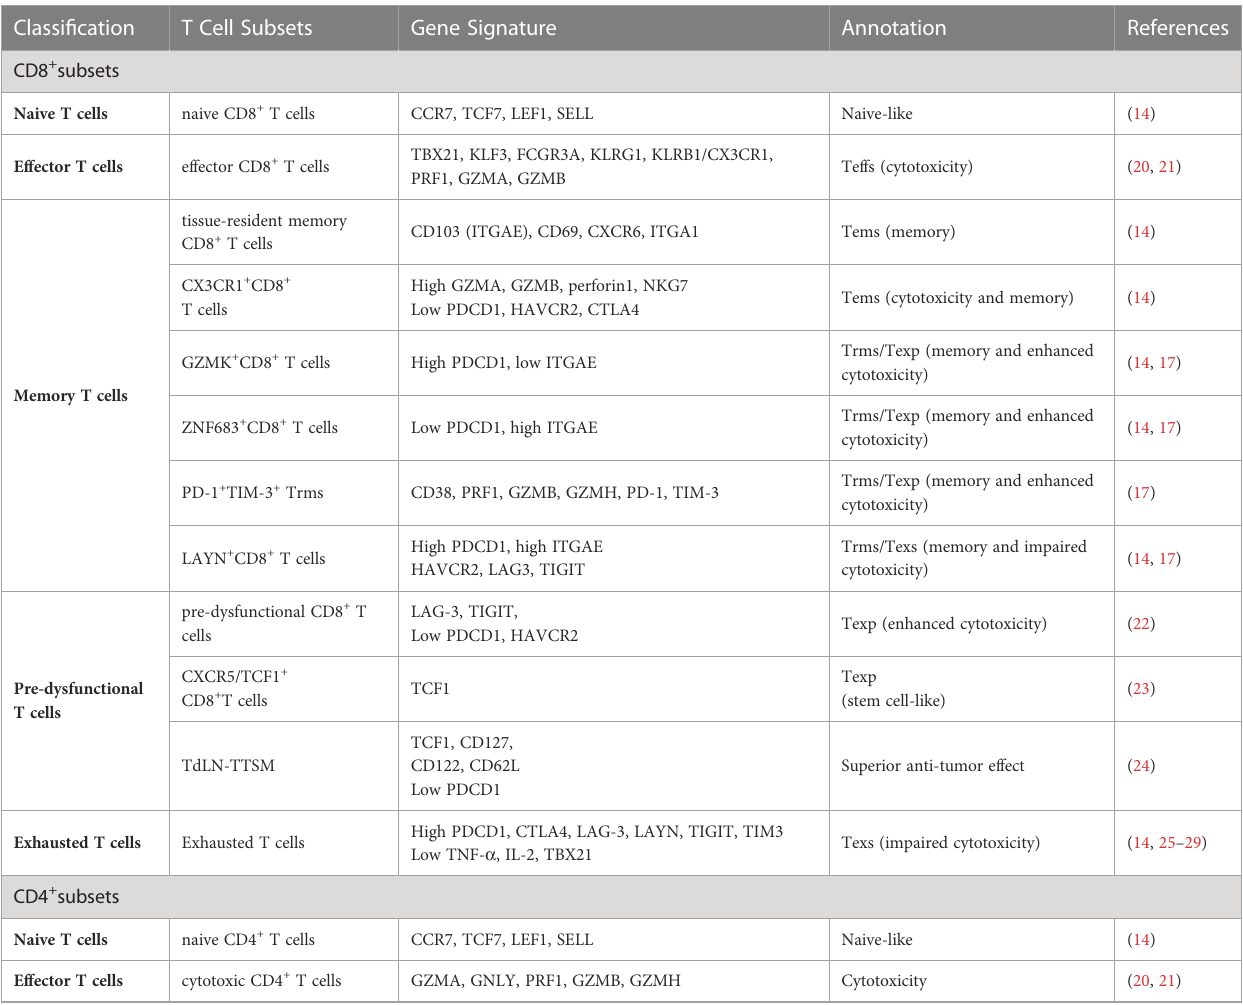
TABLE 1 T Cell Subsets revealed by